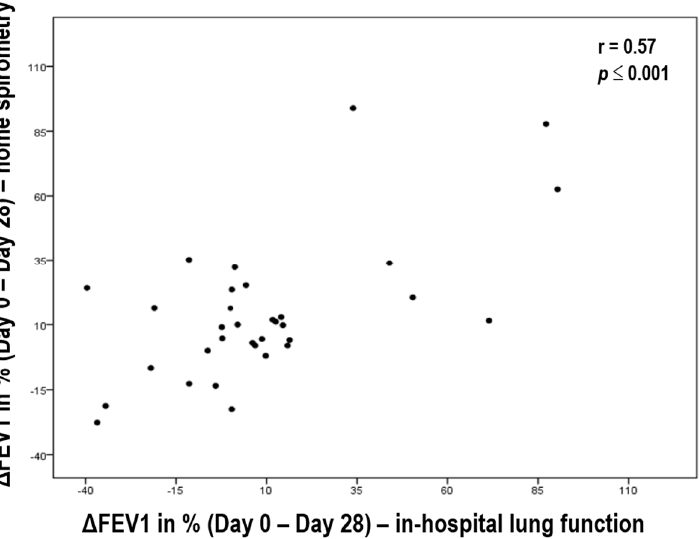
Figure 3. Correlation between home spirometry Δ FEV1 and in-hospital Δ FEV1 days 0–28.